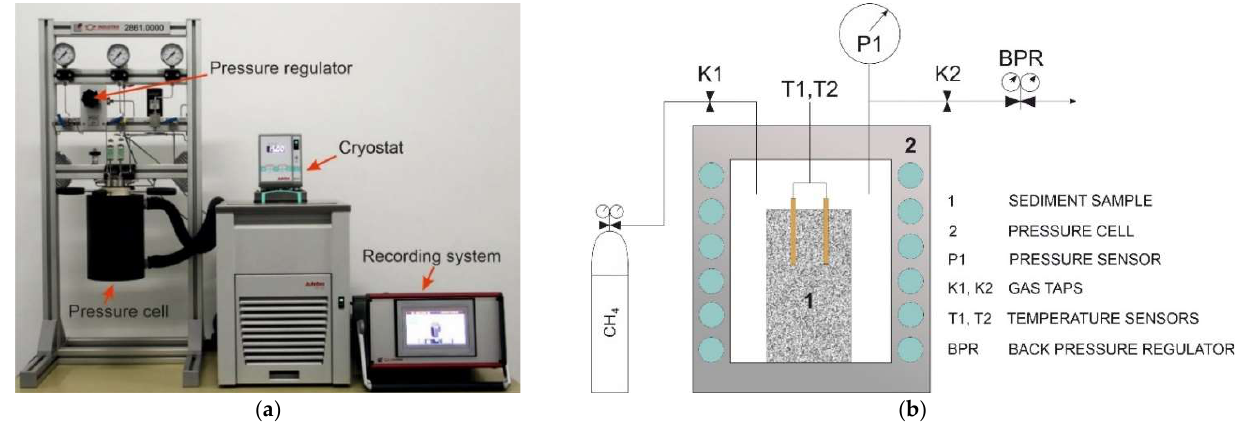
Figure 1. Top Industrie system for hydrate-saturated samples: general view ( a ) and a sketch of the pressure cell interior ( b ).